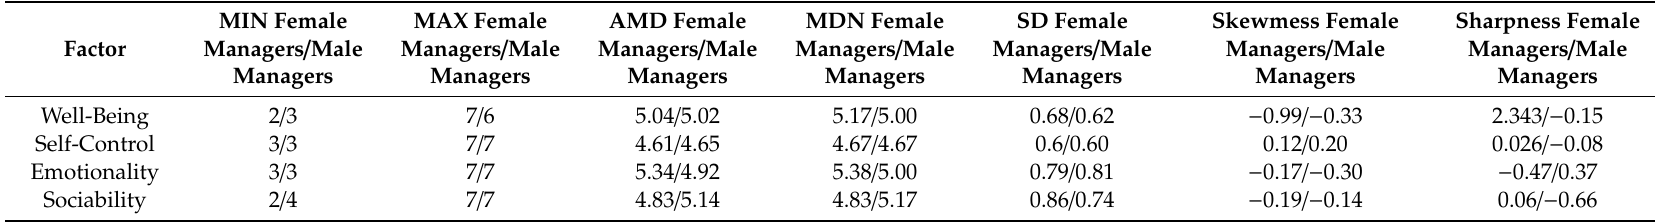
Table 5. Descriptive indicators of trait emotional intelligence factors measured by the TEIQue SF questionnaire for